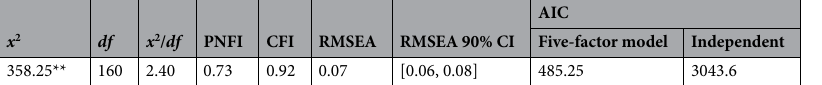
Table 4. Goodness-of-fit indices for the five-factor model. AIC Akaike information criterion, CFI comparative fit index, PNFI parsimonious normed fit index, RMSEA root mean square error of approximation. ** p <